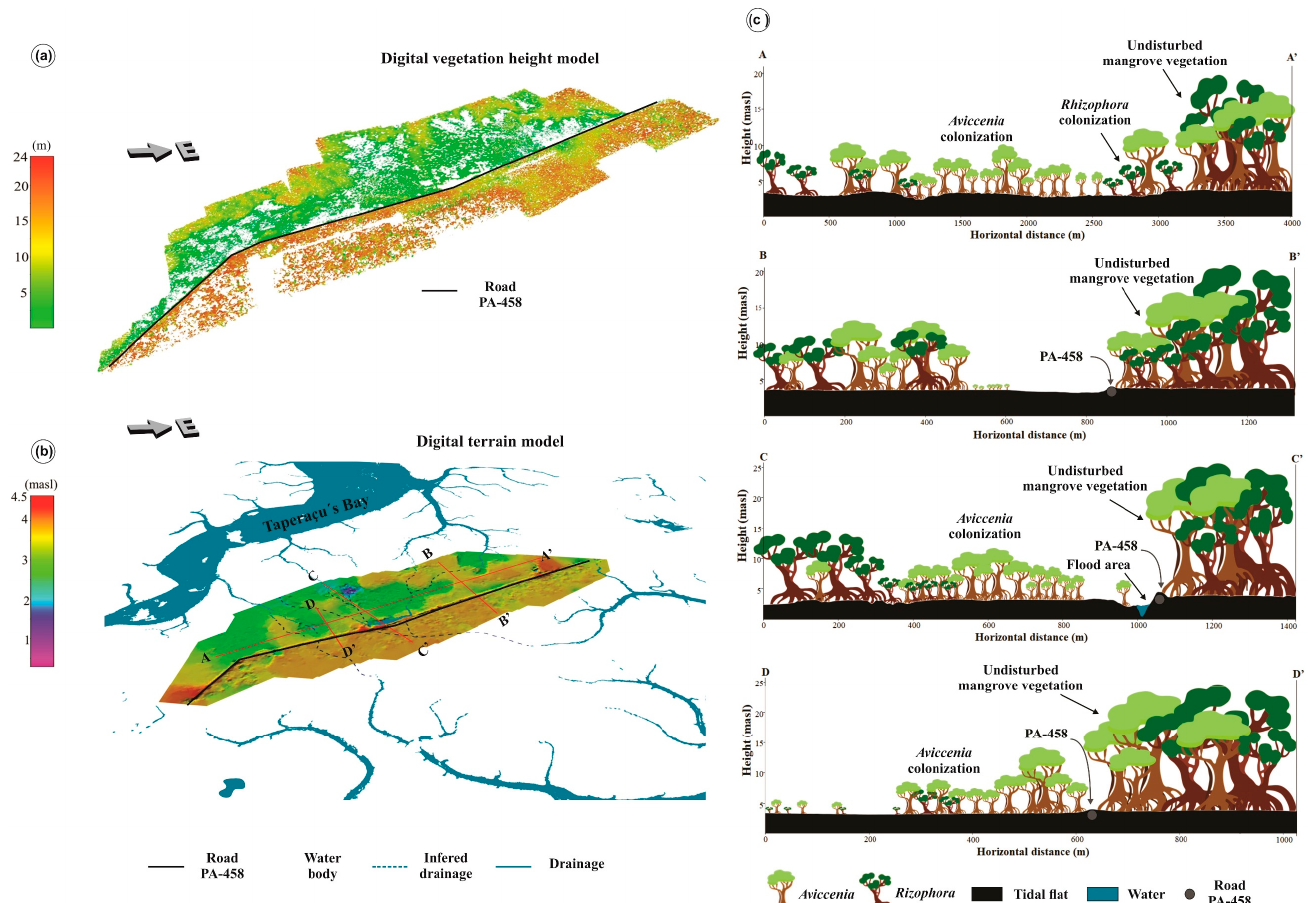
Figure 12. Digital Models for ( a ) vegetation height and ( b ) terrain. ( c ) Planialtimetric sections (A-A’, B-B’, C-C’ and D-D’) of the degraded mangrove areas near the center of the Bragança Peninsula related to mean sea level with the vegetation units and vegetation height.